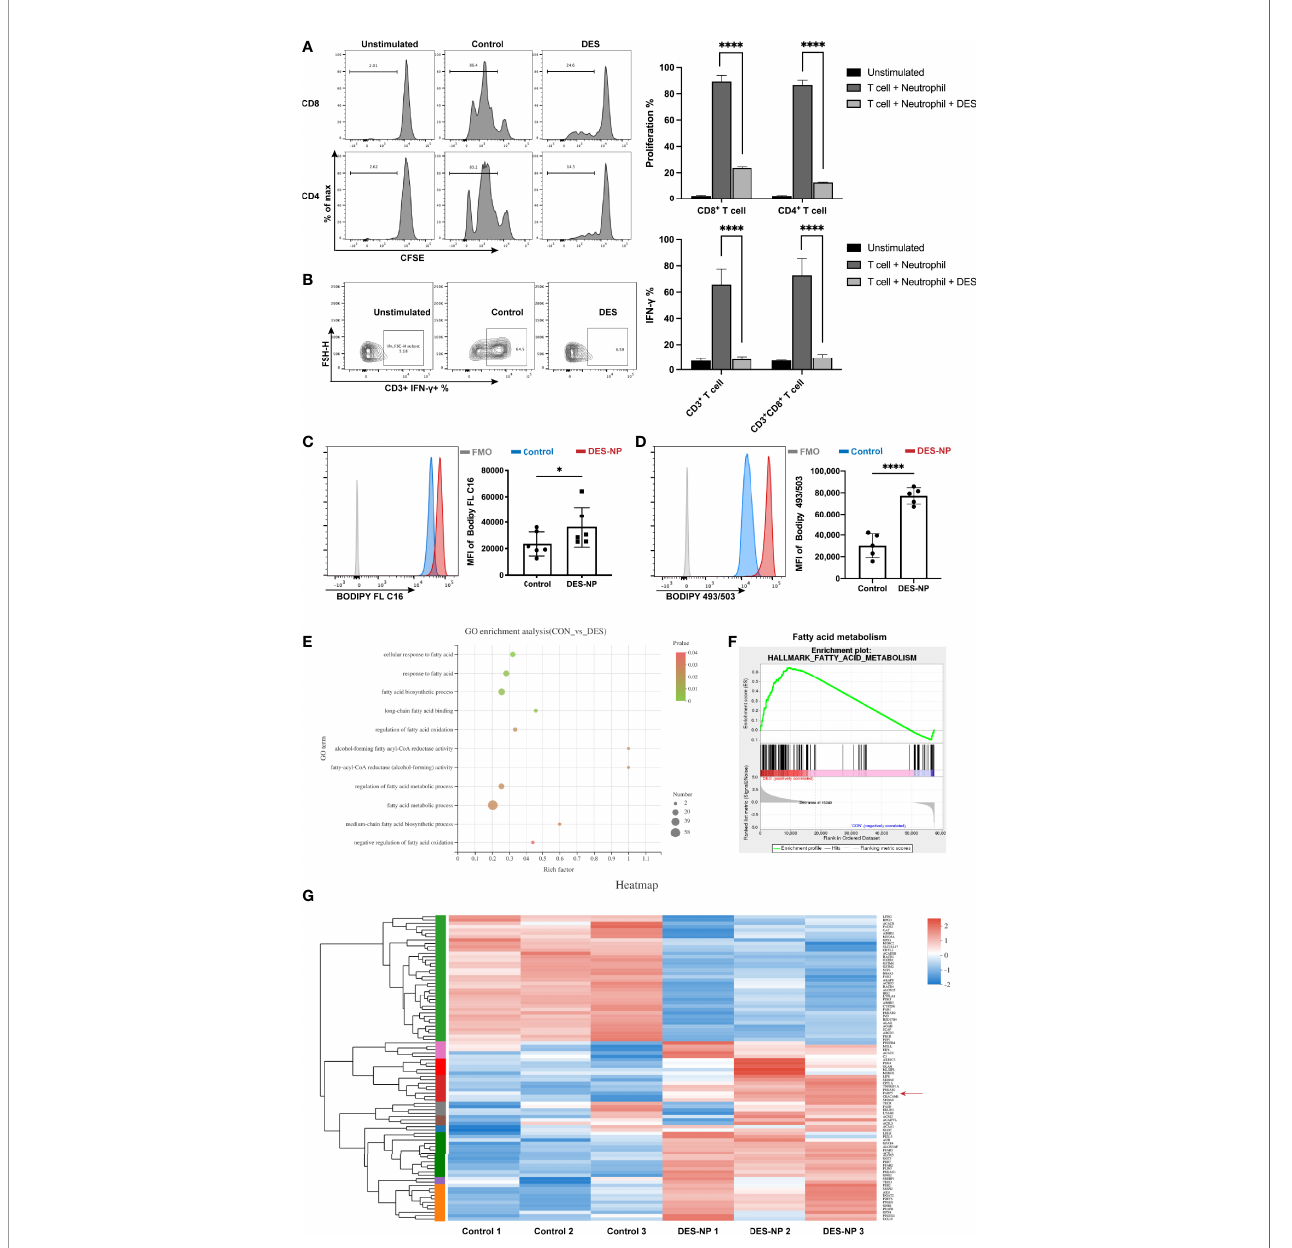
FIGURE 3 | Induced lipid accumulation and the enrichment of fatty acid metabolism after exposure to decidual explant supernatant (DES). To evaluate the functional characteristics of DES-conditioned circulating neutrophils, CD3/CD28-stimulated T cells were cocultured with circulating neutrophils from healthy donors either untreated or treated with 50% (v/v) DES at a ratio of 2:1 for 3.5 days. The proportion of proliferative CD4+ T cells or CD8+ T cells (n = 6) (A) and the percentage of IFN- g -expressing CD3+ T cells or CD8+ T cells (n = 6) (B) were analyzed. (C, D) Increased free fatty acid uptake (BODIPY FL C16) (n = 6) and intracellular lipid accumulation (BODIPY 493/503) (n = 5) were detected after exposure to DES. (E) GO terms associated with fatty acid metabolism in circulating neutrophils were upregulated after DES treatment (n = 3). (F) GSEA showing enrichment of the fatty acid metabolism gene set in the DES-condition. (G) Heatmap showing the differentially expressed genes related to lipid metabolism. All data are represented as mean ± SD. Signi fi cance was determined by the unpaired Student ’ s t-test. ****p < 0.0001, *p < 0.05. FMO, fl uorescent minus